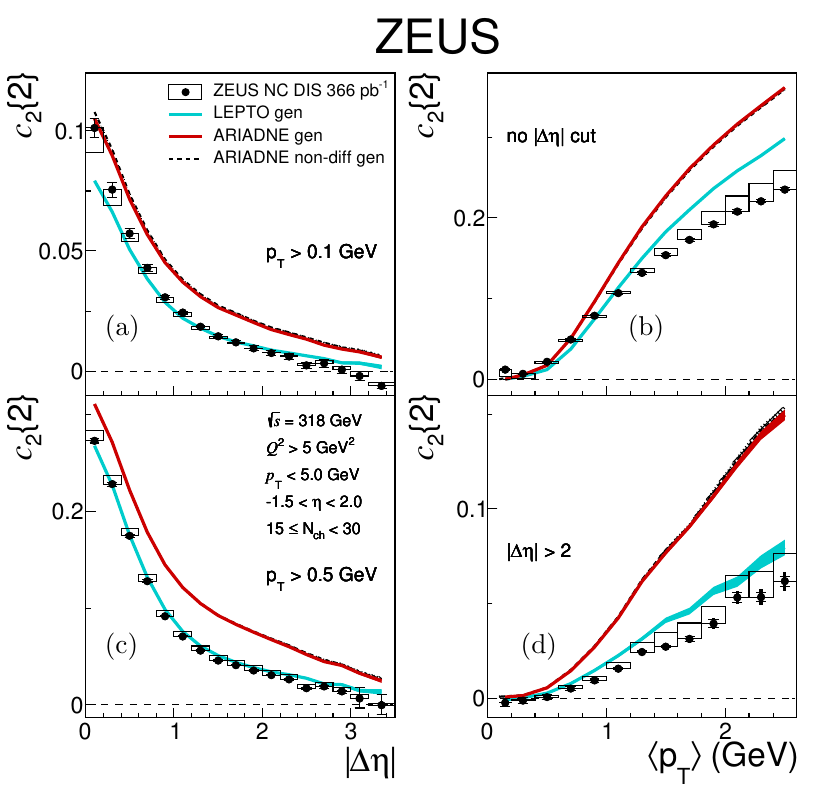
Figure 12 . Correlations c 2 f 2 g as a function of j (cid:1) (cid:17) j and h p T i for 15 (cid:20) N ch < 30. Also shown are the predictions from Monte Carlo event generators. The other details are as in (cid:12)gure 11.